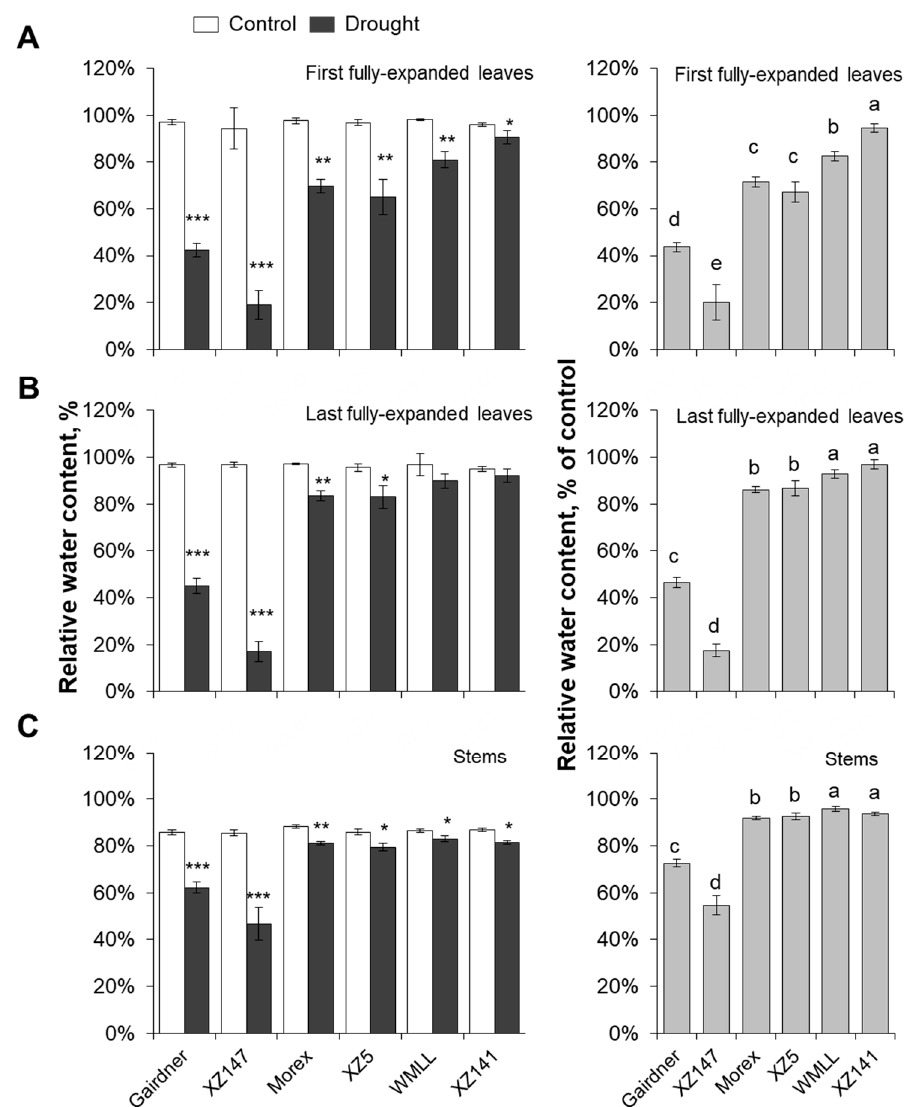
Figure 3. E ff ect of water-limited drought stress on water relation of barley seedlings. Twelve-day-old barley seedlings were subjected to drought stress. Plants were harvested for relative water content analysis in first ( A ) and last ( B ) fully-expanded leaves and stem ( C ) at 10 d after onset of treatments. Vertical bars represent means ± SE of five replicates. Asterisks indicate the significant di ff erence between treatments at * p < 0.05, ** p < 0.01 and *** p < 0.001. Di ff erent lowercase letters indicate the significant di ff erence between genotypes at p <